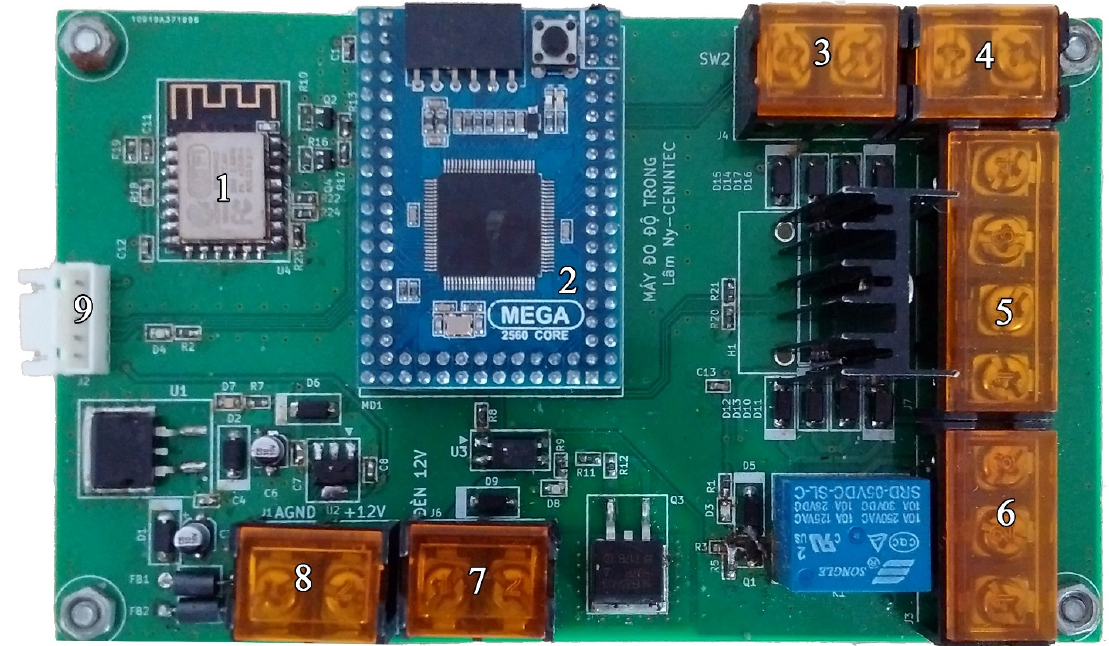
Figure 3. The hardware of the controller: (1) serial WiFi module ESP8266; (2) Arduino Mega2560-CORE; (3 and 4) switch ports; (5 and 6) connecting ports to motors; (7 and 8) 12 VDC power supply ports; and (9) TSL2560 light sensor jack